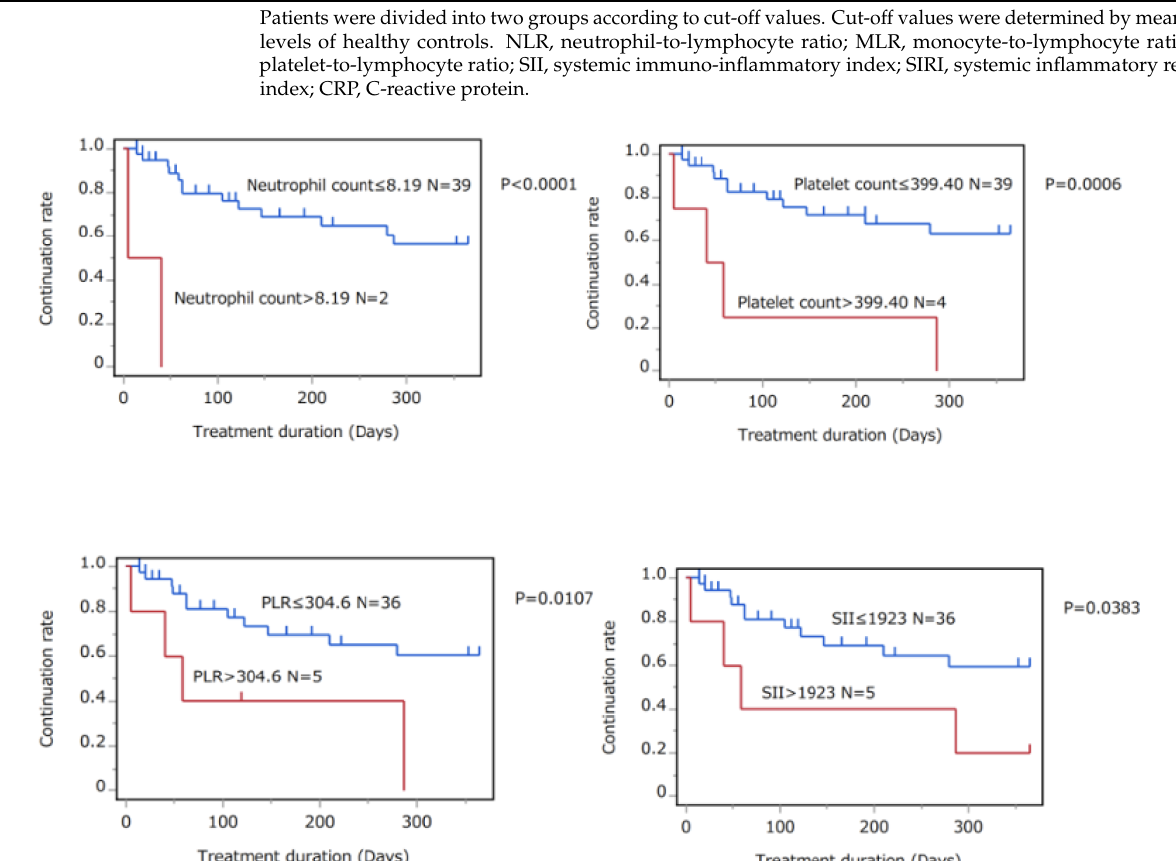
Figure 3. Kaplan–Meier curves for treatment continuation rates of patients who received treatment with oral apremilast, methotrexate, cyclosporine, and etretinate. Patients were divided into two groups by pretreatment scores according to the cut-off values and determined by mean + 2SD levels of healthy controls (neutrophil counts; >8.19 × 10 9 /L, N = 2 and ≤ 8.19 × 10 9 /L, N = 39, platelet counts; >399.40 × 10 9 /L, N = 4 and ≤ 399.40, N = 39, PLR; >304.6, N = 5 and ≤ 304.6, N = 36, and SII; >1923, N = 5 and ≤ 1923, N = 36). The continuation rates of the two groups were compared by log-rank test.